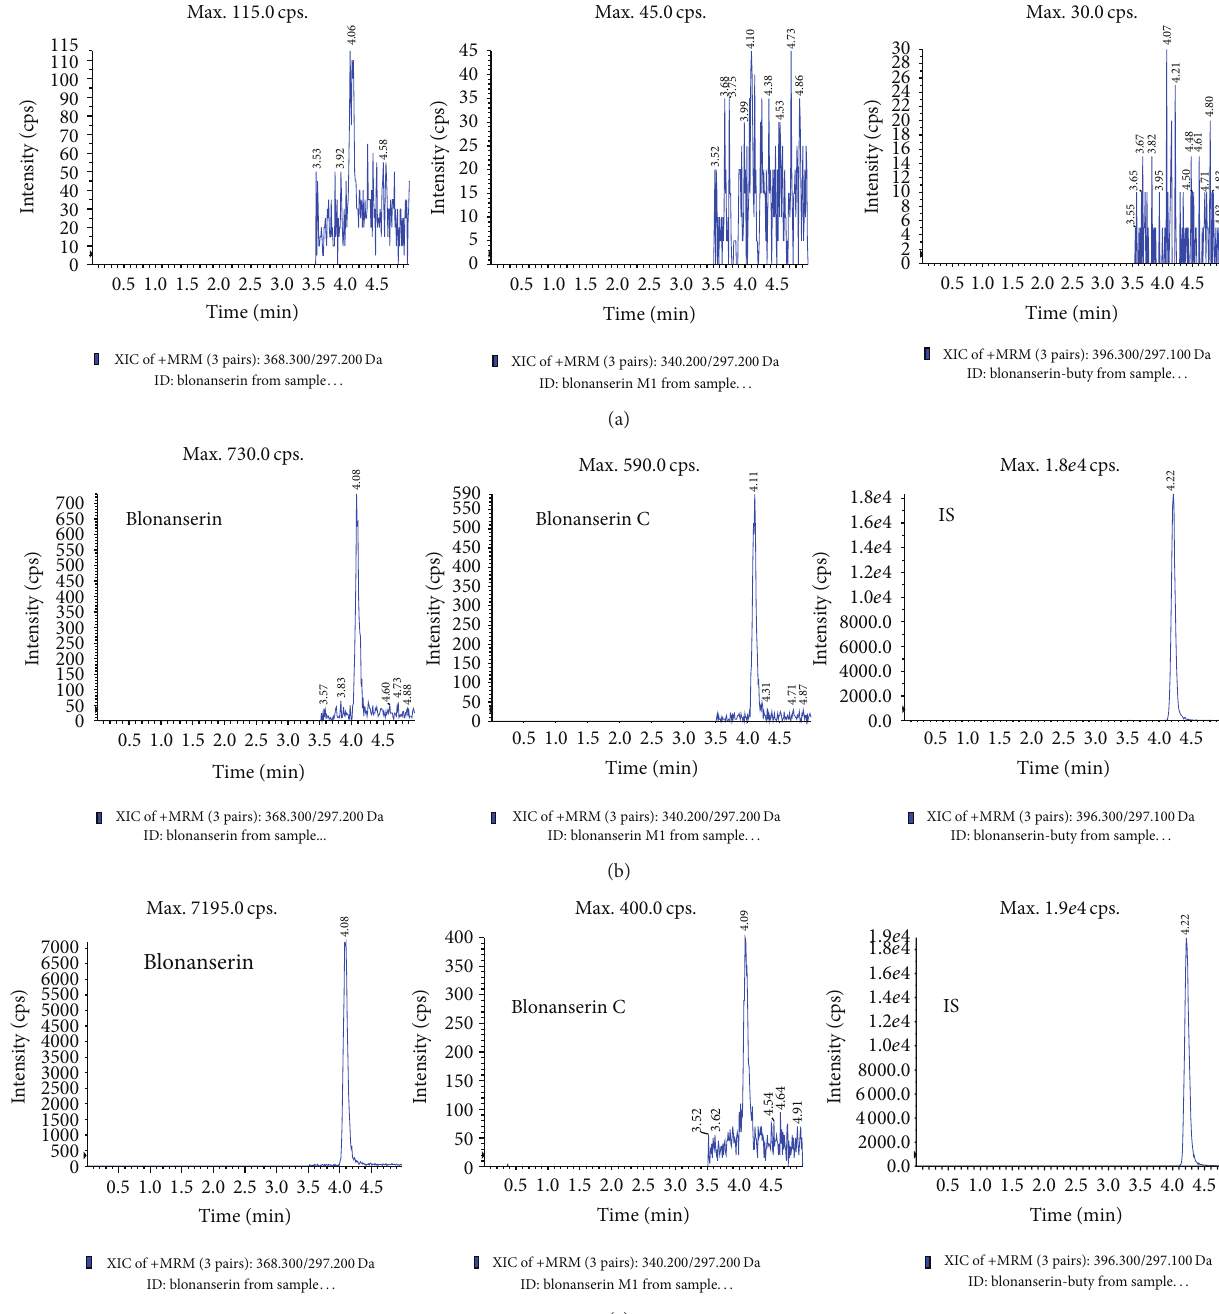
Figure 2: MRM chromatograms of blonanserin, blonanserin C, and IS obtained from human plasma samples: (a) blank plasma; (b) blank plasma spiked with standard solution (LLOQ); (c) plasma sample from a healthy subject 1.5 h after oral administration of 8mg blonanserin